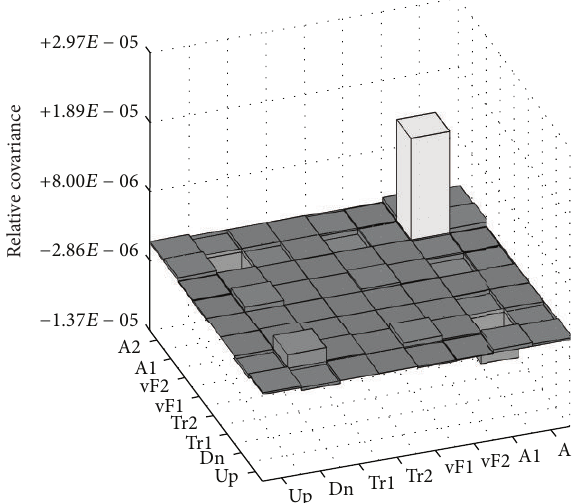
Figure 24: Homogenized property covariance due to 𝜎 U 238 𝛾 covari- ance using FCWG.